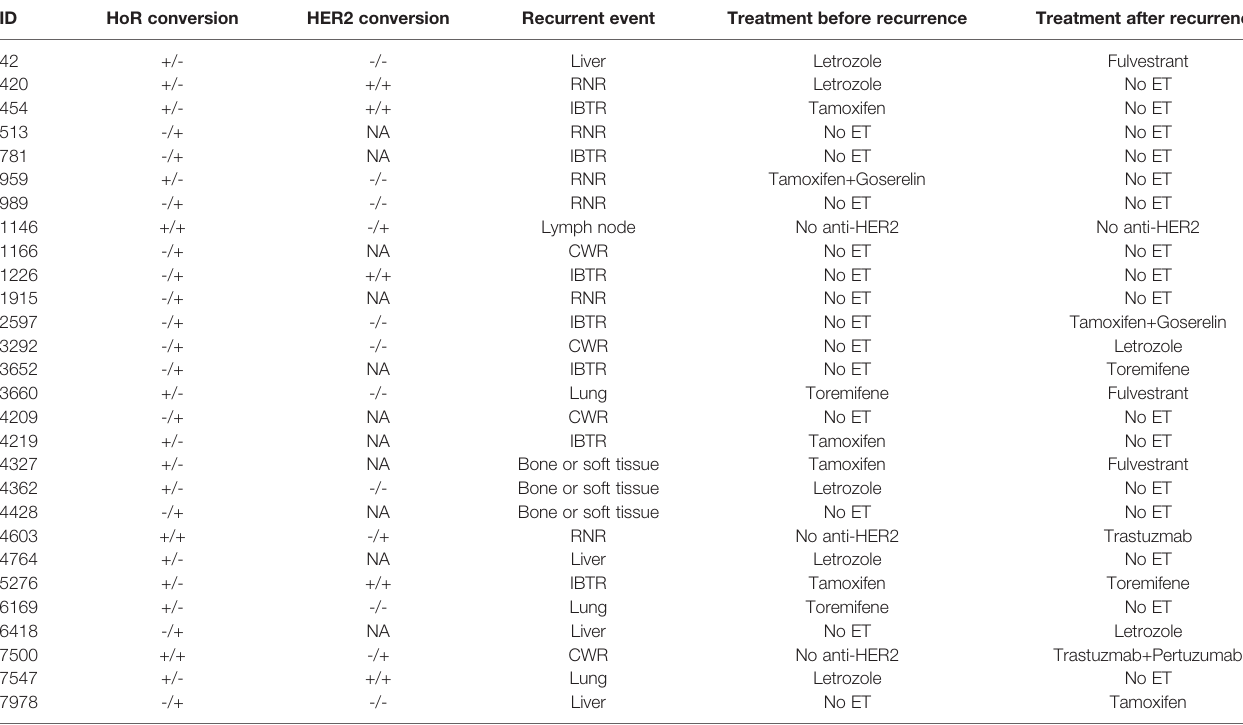
HoR, hormone receptor; HER2, human epidermal growth factor receptor-2; +/-, from positive to negative; -/-, remain negative; +/+, remain positive; RNR, regional node recurrence; ET, endocrine therapy; IBTR, ipsilateral breast tumor recurrence; -/+, from negative to positive; NA, not available; CWR, chest wall